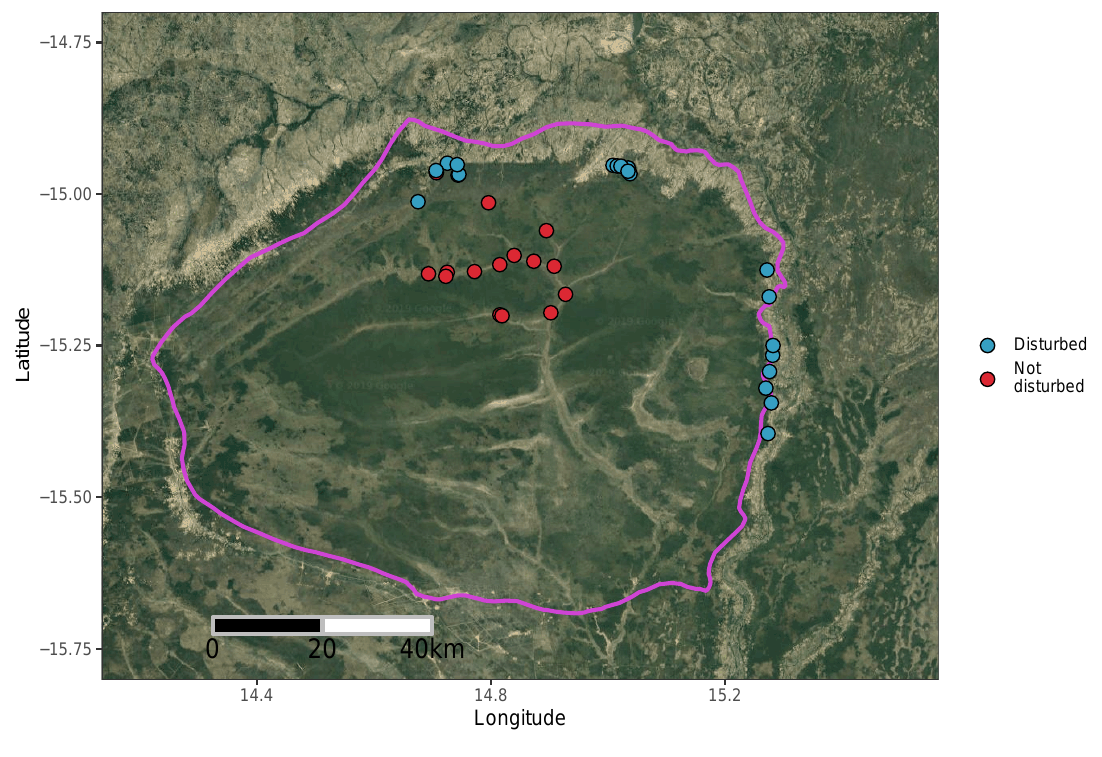
Figure 2. Location of plots in Bicuar National Park, southwest Angola. The Park boundary is shown as a pink outline, according to UNEP-WCMC and IUCN [38]. One hectare undisturbed plots are shown as red points, while disturbed 20 × 50 m (0.1 hectare) plots are shown as blue points. The map background is a true colour composite satellite image generated using the Google Maps Static Maps API in the ggmap R package